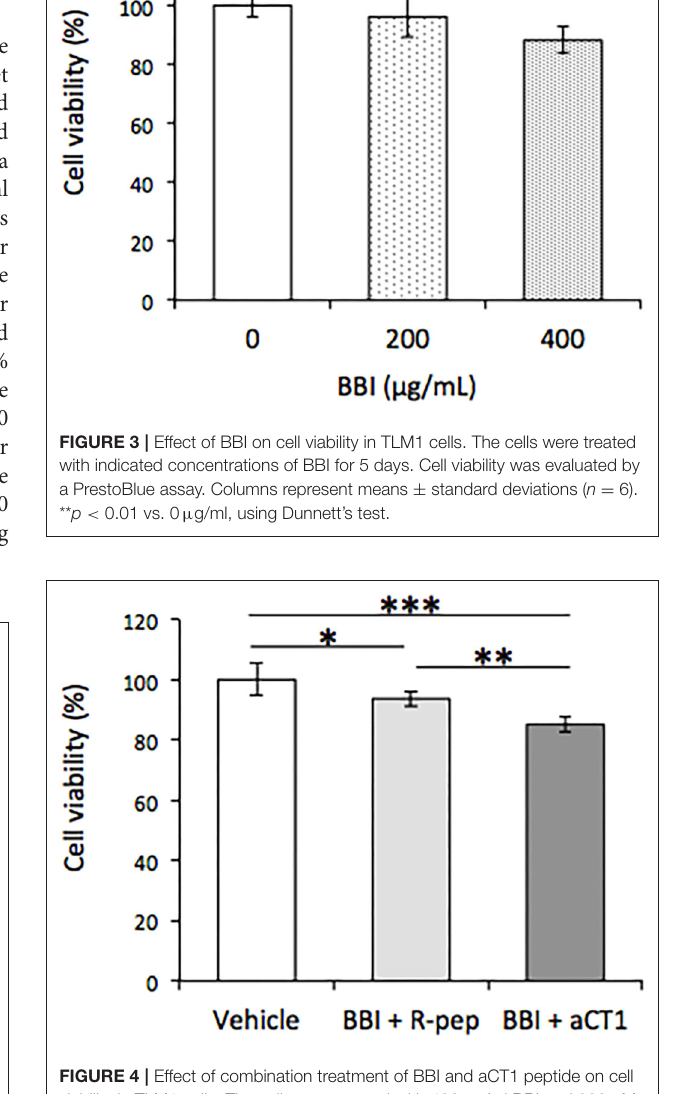
FIGURE 2 | Effect of aCT1 peptide on cell viability in TLM1 cells. The cells were treated with 200 µ M aCT1 or the reverse sequence peptide (R-pep) for 5 days. Cell viability was evaluated by a PrestoBlue assay. Columns represent means ± standard deviations ( n = 5).